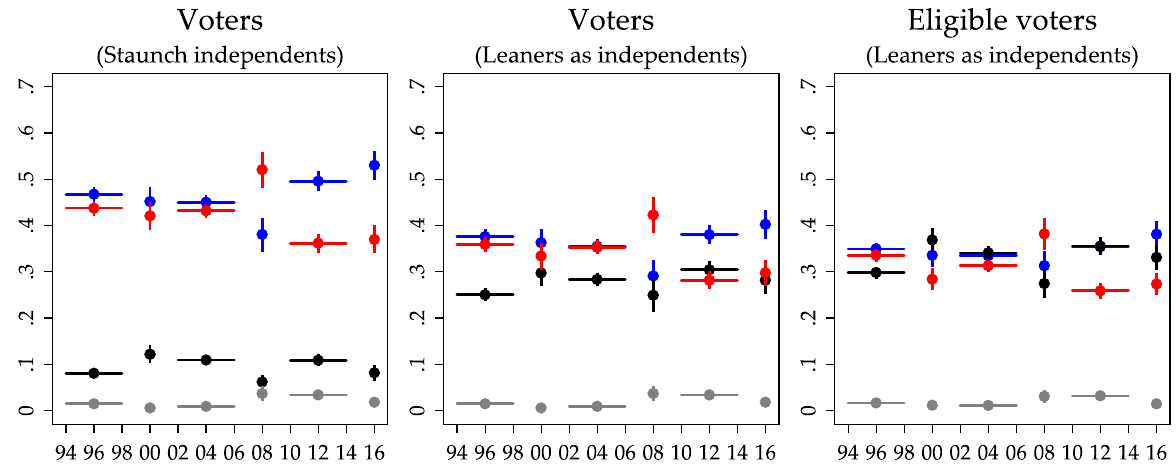
Figure 7: Class IIIa trends in identification with the Democratic Party (blue), Republican Party (red), another party (gray), and independent